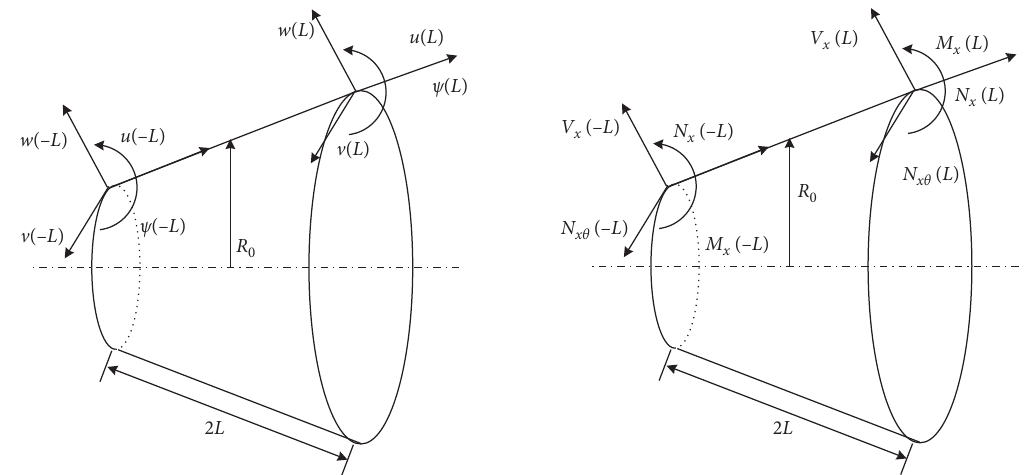
Figure 2: Displacement and force at boundary node of conical